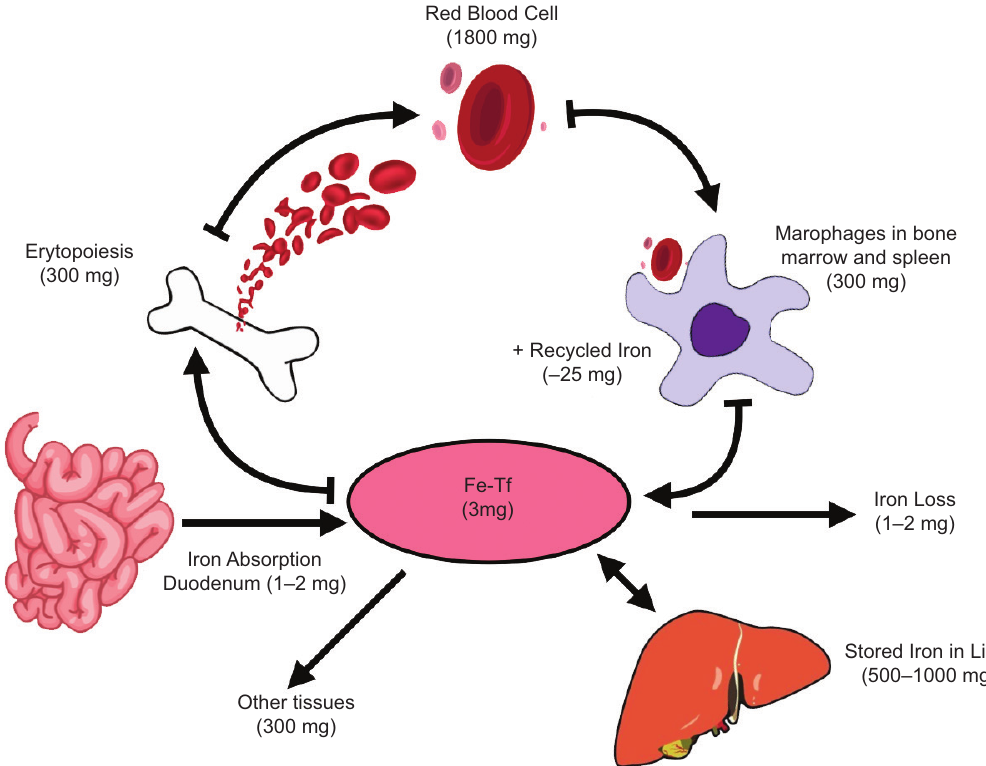
Figure 1: Iron metabolism and